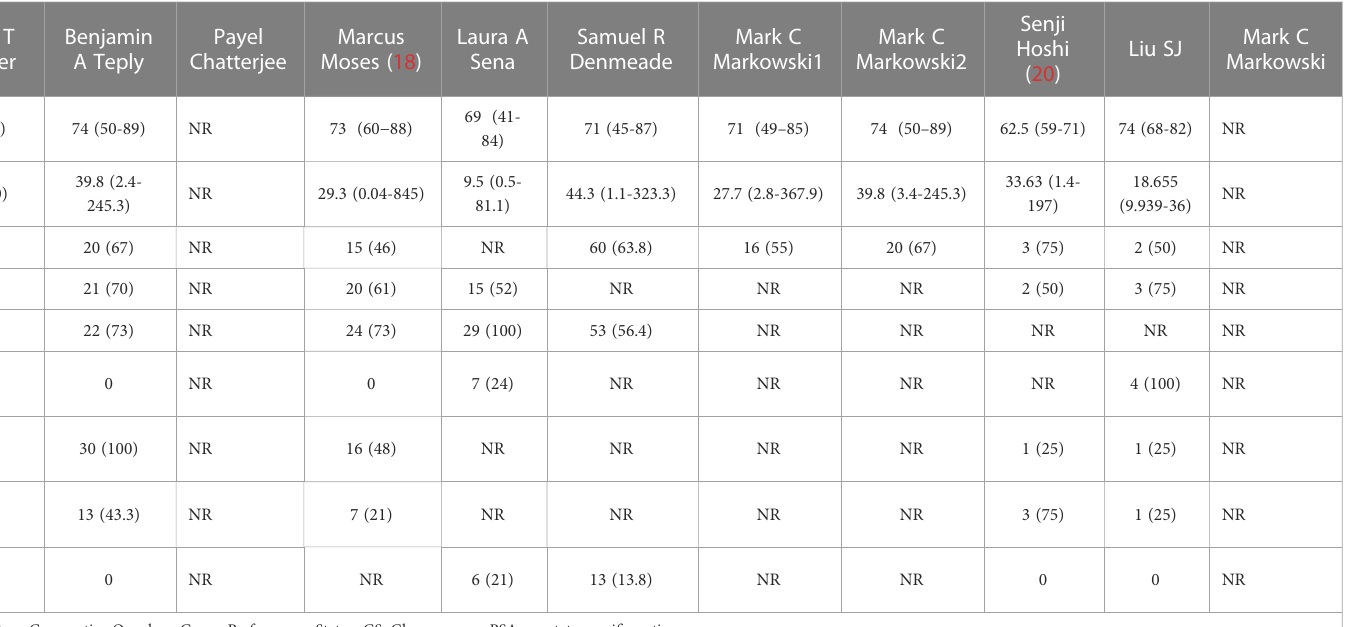
TABLE 2 Baseline characteristics for patients of included